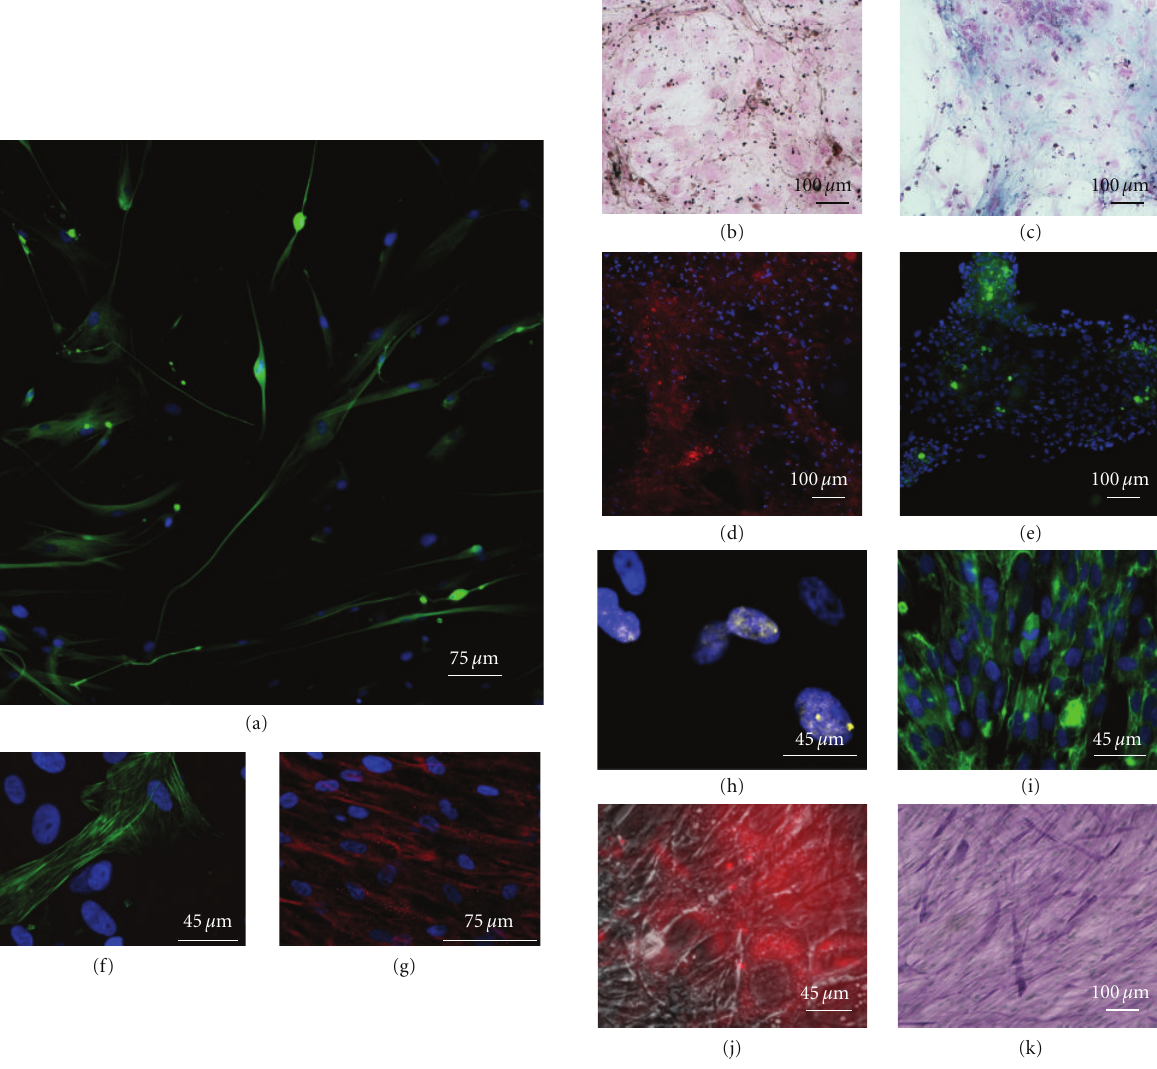
Figure 3: Multipotency of MASCs obtained from neoplastic livers. A neuroectodermic di ff erentiation: N-MASCs (a) in neurogenic medium acquired the expression of β 3-tubulin (green fluorescence). (b–e) Osteogenic di ff erentiation: N-MASCs in osteogenic medium display positivity for von Kossa (b) and Alcyan blue (c) cytochemistry reactions, were able to incorporate tetracycline in sites of calcification when excited with a UV laser (red fluorescence, (d)) and presented osteocalcin deposits (green fluorescence, (e)). (f, g) Myocyte di ff erentiation: a low fraction of N-MASCs in di ff erentiation medium express the myocyte-specific filament SMA (green fluorescence, (f)), while the large part of the cells expresses α -sarcomeric actin in the cytoplasm (red fluorescence, (g)). (h–k) Endodermic di ff erentiation: cells cultured for one week in a medium added with HGF and FGF-4 became positive for GATA-4 (yellow fluorescence, (h)). Cells cultured for three weeks in the same medium became positive for cytokeratins 8–18-19 (green fluorescence, (i)) were able to actively uptake DiI-labeled acetylated LDL (red fluorescence overlaid on a phase contrast image, (j)) and presented diastase-resistant glycogen granules, as revealed by PAS reaction (purple stain, (k)). In the fluorescence pictures, nuclei are depicted by the blue fluorescence of DAPI